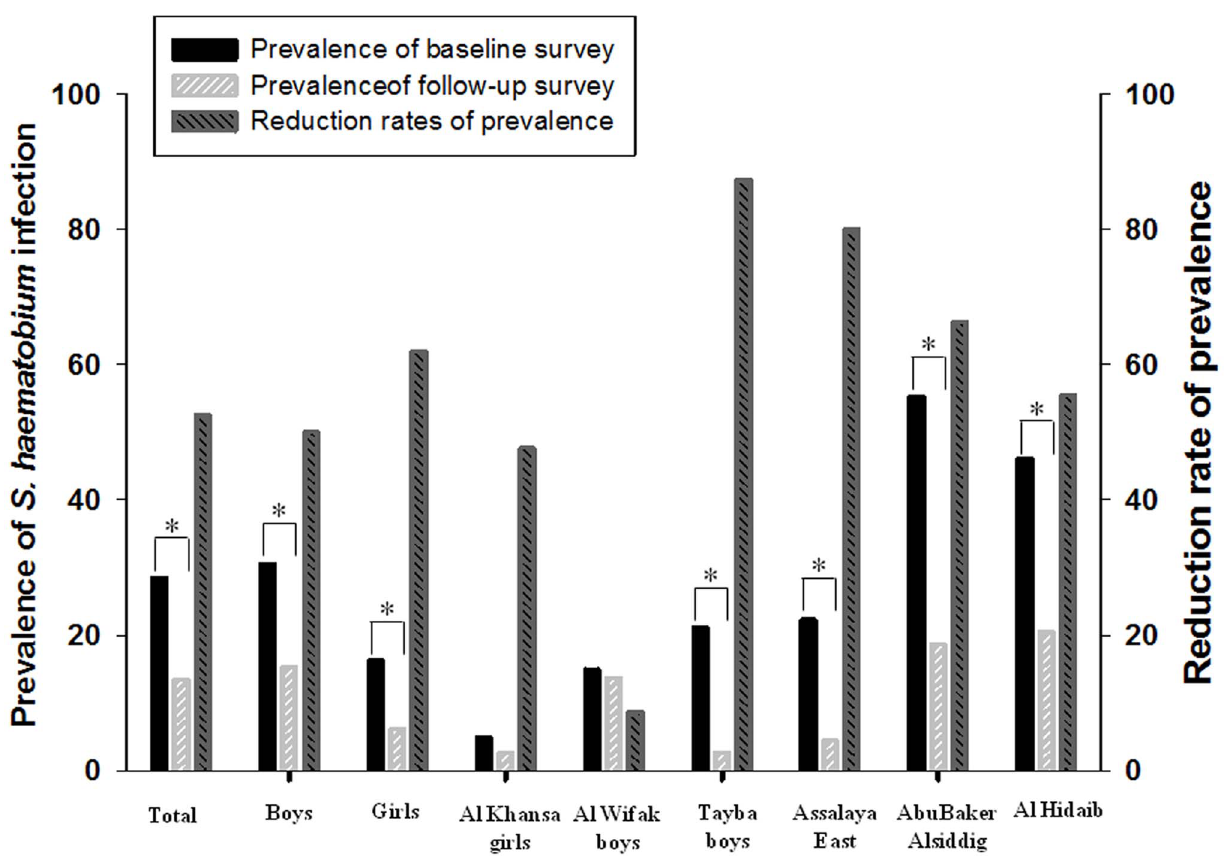
Fig. 6. Reduction in the prevalence of S.haematobium infection between the baseline and follow-up surveys. The baseline survey was done at 61 primary schools in Al Jabalain locality before treatment, and the follow-up survey was conducted at 12 schools 6–9 months after the chemotherapy. The reduction rates of prevalence were calculated by [(baseline prevalence - follow-up prevalence)/baseline prevalence] 6 100. The figure presented the S. haematobium infection rates of total population, total males and total females, and also showed the representative schools according to the reduction rates of prevalence (low, Al Khansa girls and Al Wifak boys; high, Tayba boys and Assalaya East; middle, AbuBaker Alsiddig and Al Hidaib). * P , 0.001, significant difference in S. haematobium prevalence between baseline and follow-up surveys.